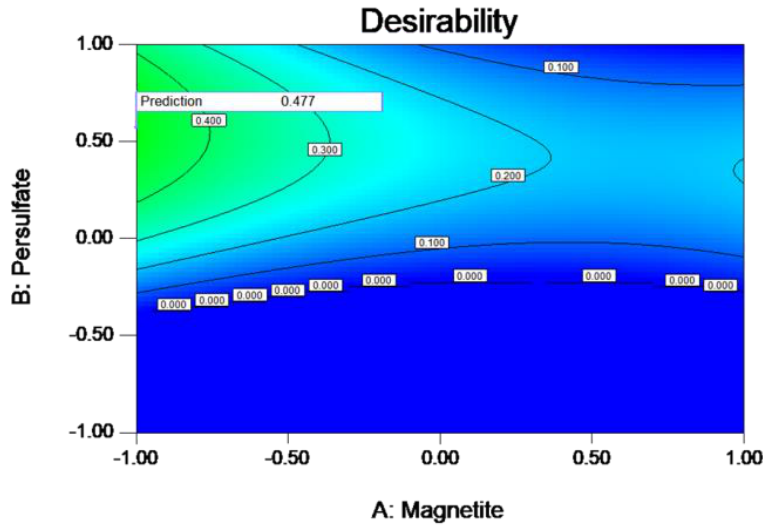
Figure 11. Optimization of experimental conditions.